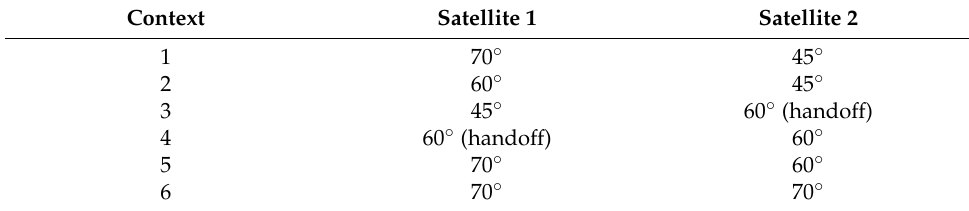
Table 4. Satellite elevation angles in each context.